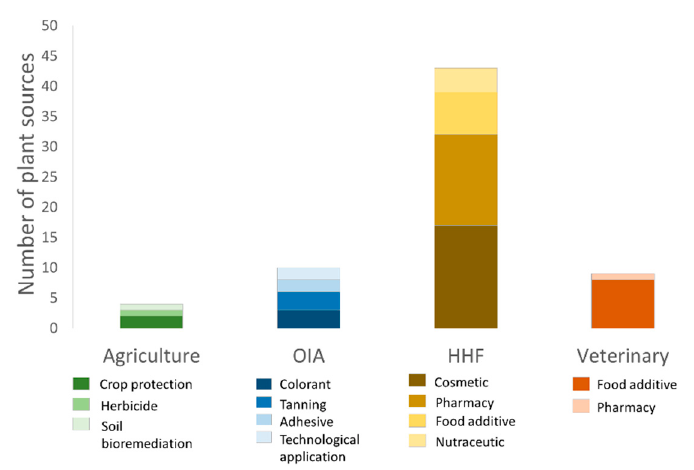
Figure 6. Number of plant matrices investigated for potential application in four different areas: agriculture, OIA (Other Industrial Applications), HHF (Human Healthcare and Food), and veterinary science. The graphic summarizes the results of our bibliographic survey (from 2006 to 2020). In particular, Anacardium occidentale L. nut shells and Castanea sativa burs proved good sources of molecules endowed with pesticide and anti-fungal properties, respec ‐ tively. On this basis they could find application as crop protection agents. Spent coffee ground showed allelopathic activity, which is useful for herbicide products.